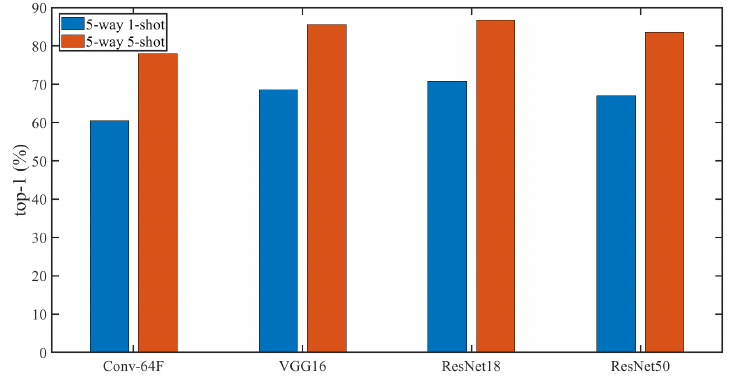
Figure 9. Classification results of our method using different embedding networks on the NWPU- RESISC45 dataset.